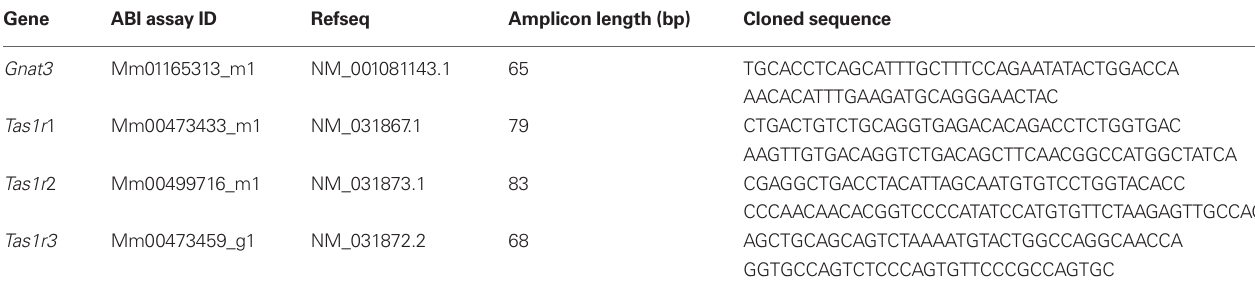
Table 1 | Details on taste gene amplifi cation from brain tissue. Gene ABI assay ID Refseq Amplicon length